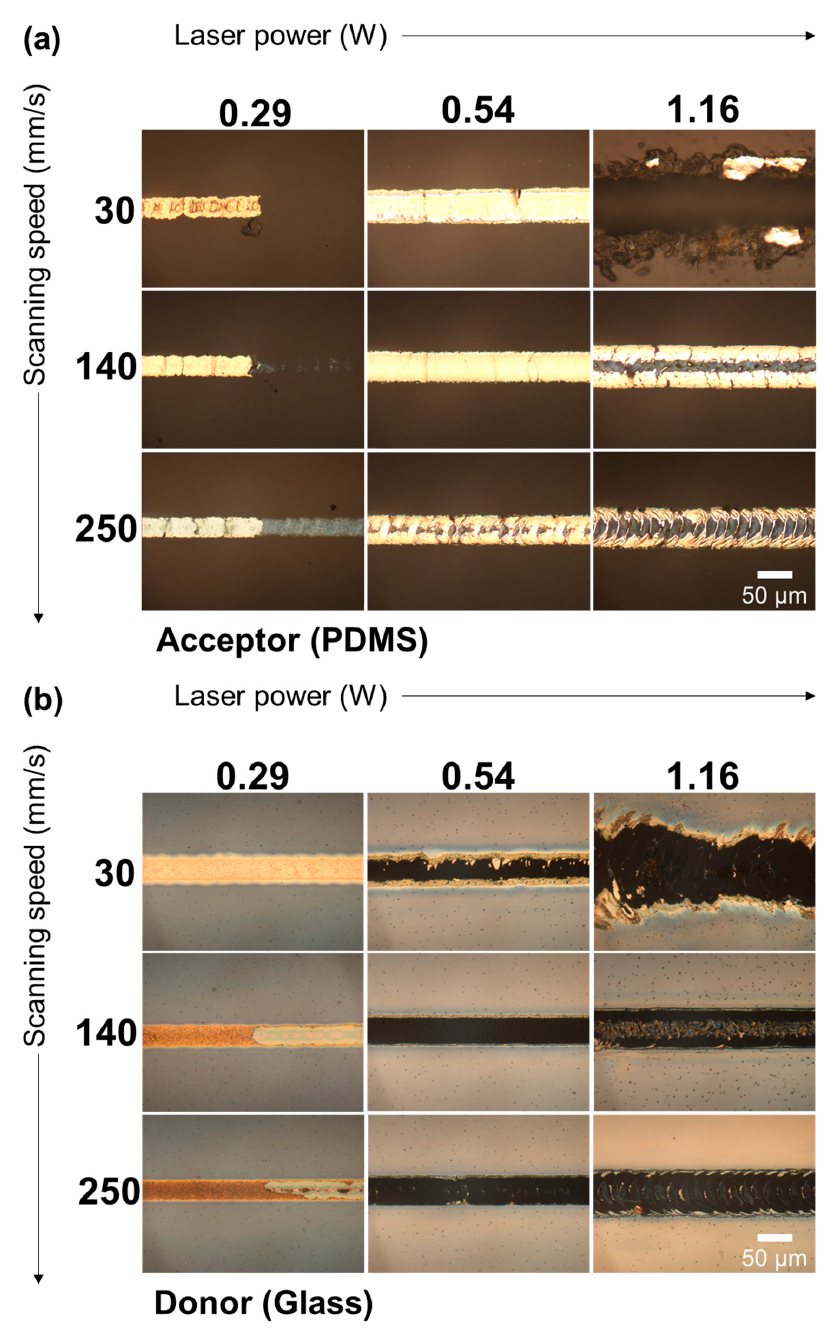
Figure 3. Combinatorial study for optimum laser power vs. laser scanning speed. Reflection optical microscope image of ( a ) the PDMS acceptor and ( b ) the Ag NP layer donor on a glass